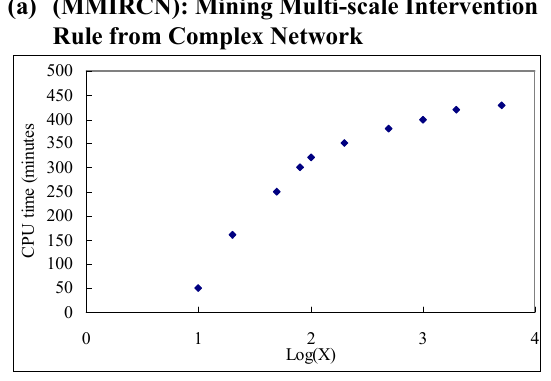
Fig. 8. Intervention rules from breath rate to heart rate of the original time series Fig 9. Performance of algorithms for MMIRCN Figure 9 depicts the increase of computing time with the increase of X (X is defined in table 2). In algorithm 2, line 2 consumes the majority of the CPU time. It will traverse graph G’ |Sub_G| times (|Sub_G| is the number of nodes in Sub_G). G’ is the graph that don not contain those nodes with citation number larger than X. Thus if X is small, a lot of nodes will be remove from G to form G’. The computing time will be decreased. (b) (MMIRTS): Mining Multi-scale Intervention